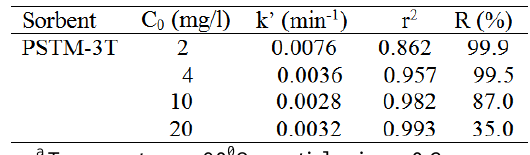
Table 5. The first-order reaction rate constants for PSTM-3T at differentinitial concentrations a